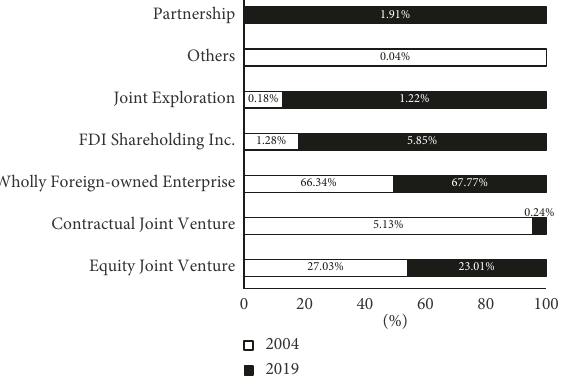
Figure 3: Proportions of FDI used by enterprises of different ownership types in China.